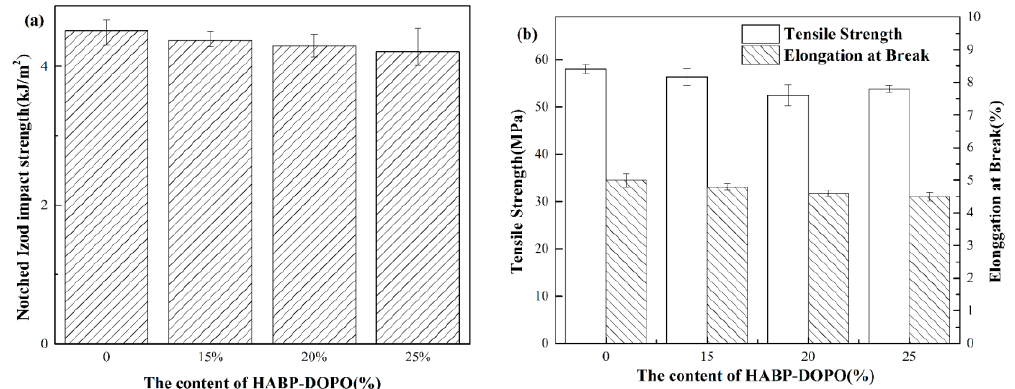
Figure 11. Mechanical properties of PLA and its blends: ( a ) notched impact strength and ( b ) tensile strength and elongation at break.